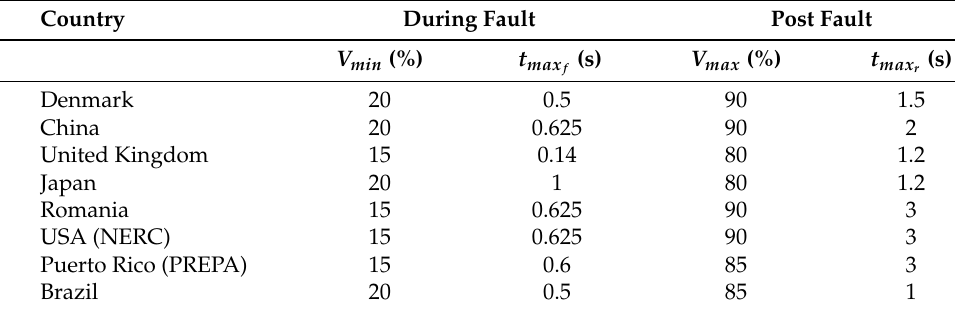
Table 2. Parameters of the LVRT in various